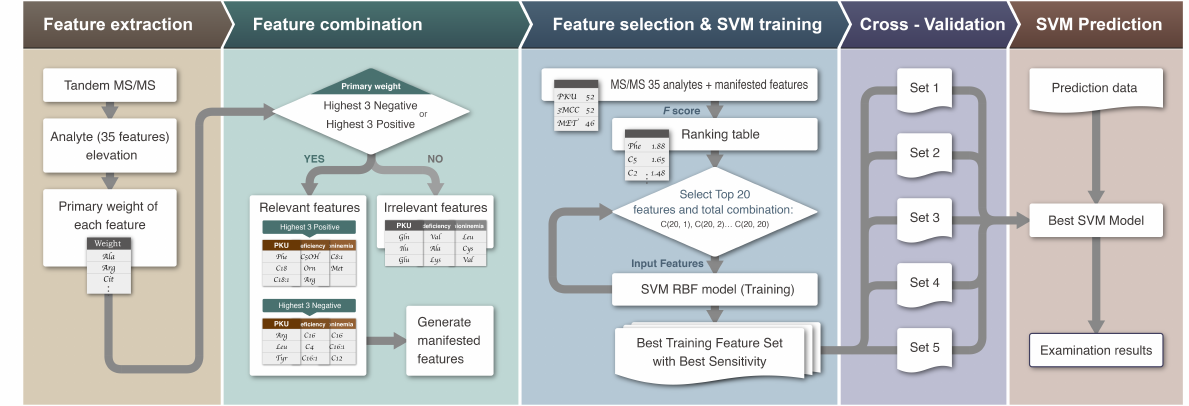
Figure 3. Training and prediction